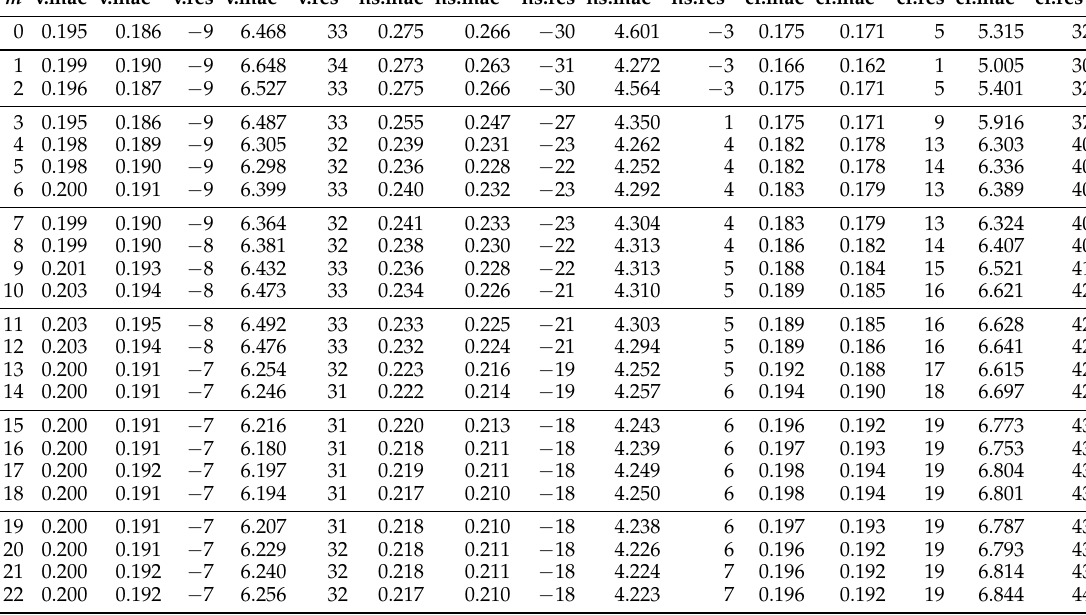
Table A27. Iteration-wise out-of-sample validation figures in adaptive variance model selection of BEL corresponding to M max 2,6,10,14,18,22 based on the 300–886 OLS proxy function given in ∈ { } Table A3 with exponents summing up to at max two. Simultaneously type I FGLS regression